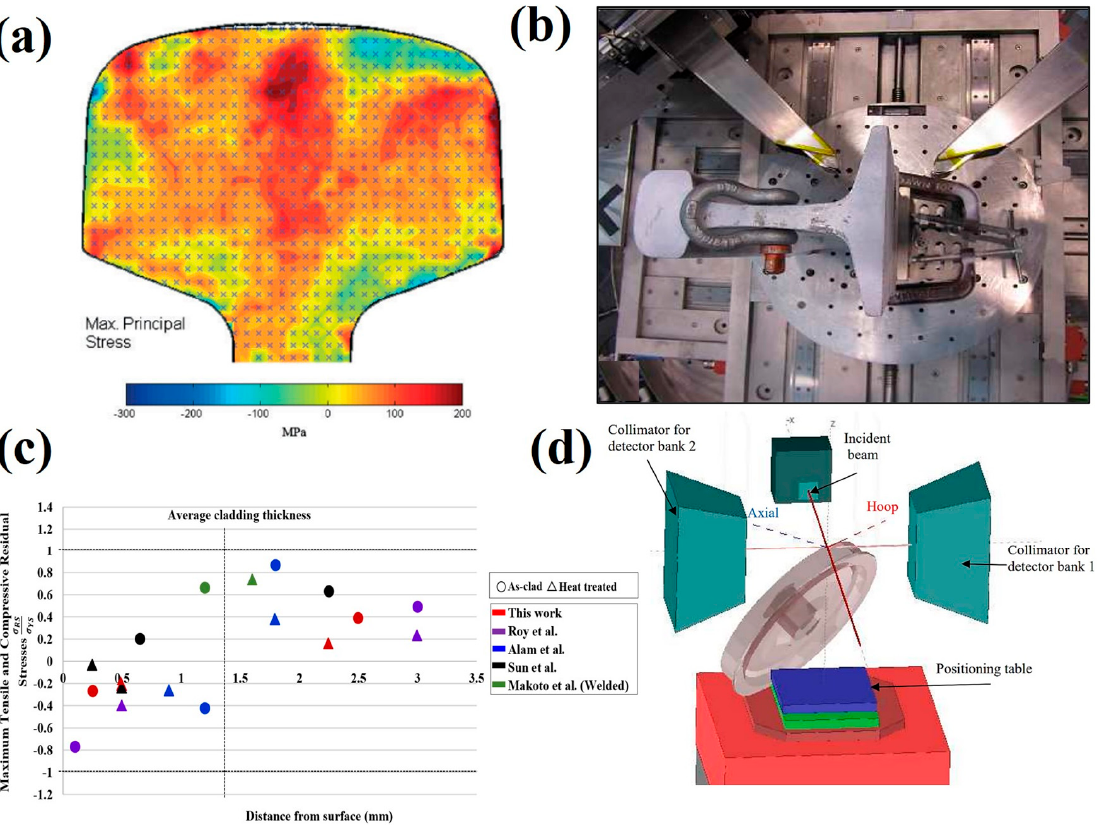
Figure 9. ( a ) Stress map of railhead by Jun et al. [80] ( b ) experimental setup of a rail on a neutron diffractometer stage by Khodabakhshi et al. [83] ( c ) comparison of neutron diffraction obtained measurements in laser clad rail by Kendall et al. with other studies [6] and ( d ) experimental setup for train wheel stress measurements by Alessandroni et al.